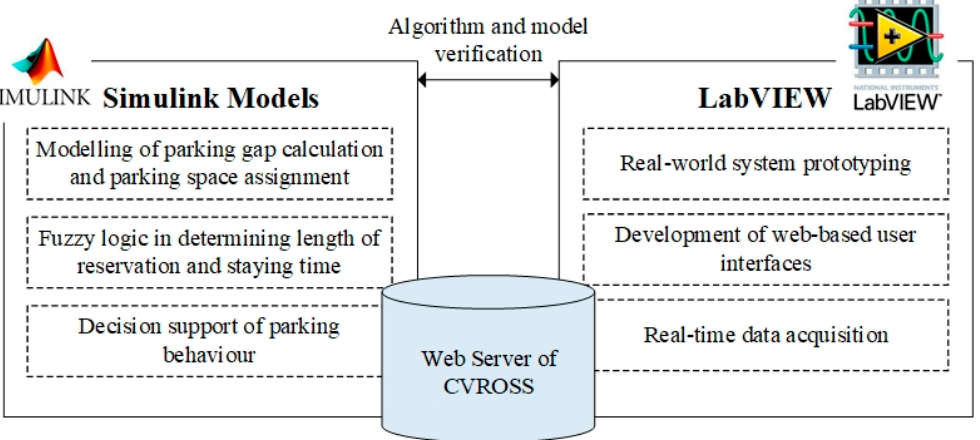
Figure 11. System deployment environment of the CVROSS.